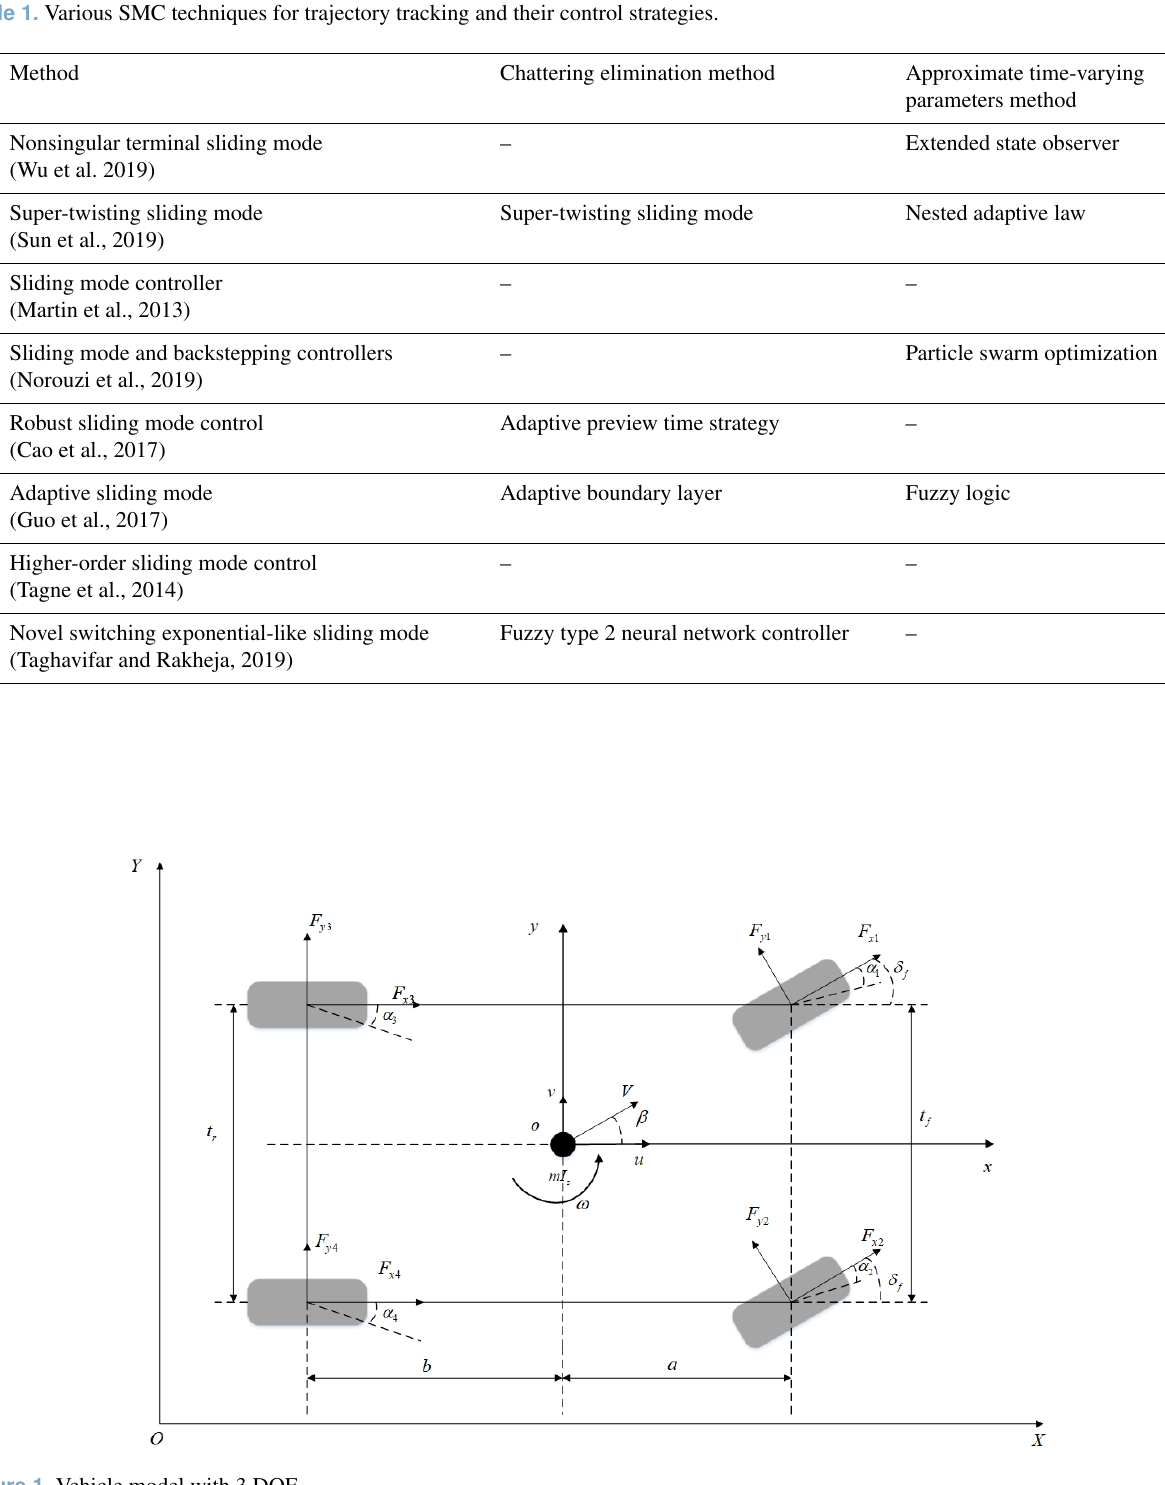
Table 1. Various SMC techniques for trajectory tracking and their control strategies.